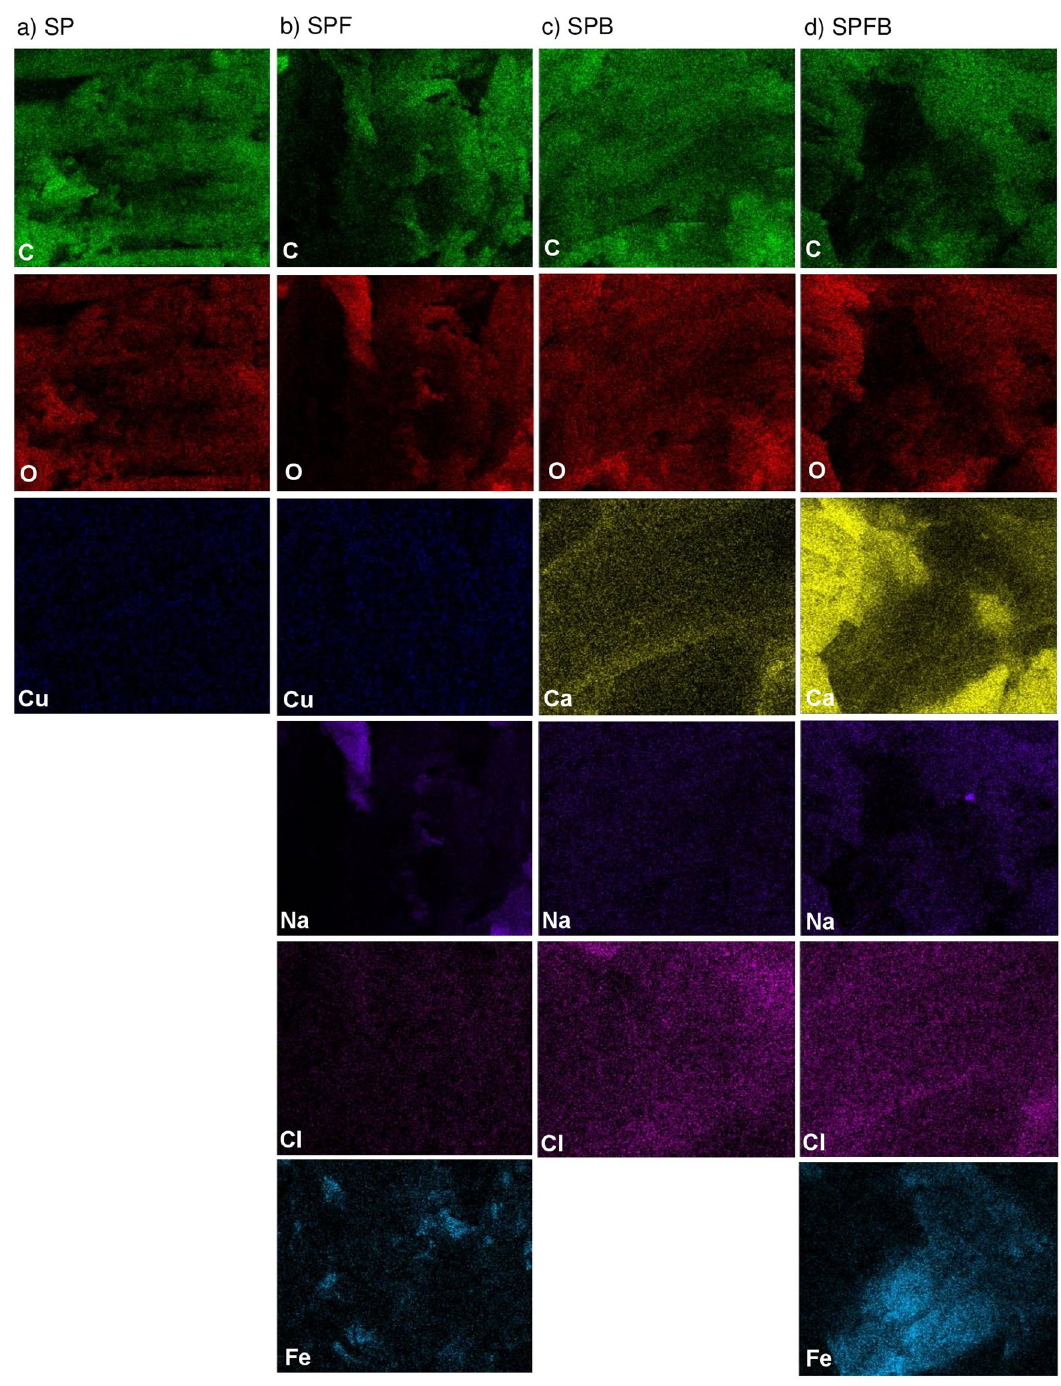
Figure 3. The elemental mapping of ( a ) sawdust powder (SP), ( b ) sawdust powder doped iron (III) oxide- hydroxide (SPF), ( c ) sawdust beads (SPB), and ( d ) sawdust powder doped iron (III) oxide-hydroxide beads (SPFB) on the